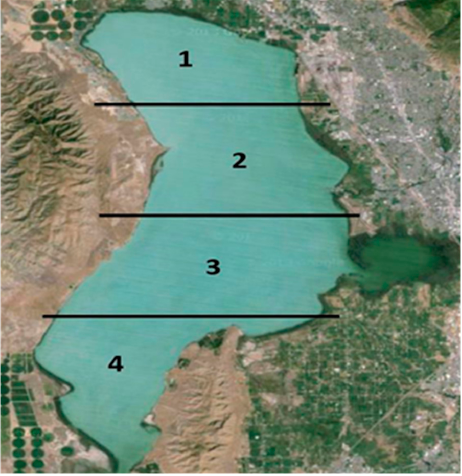
Figure 6. The four sections used for analysis of the Utah Lake sediment data. Table 2. Statistical summary for samples from each of the four lake sections and from the land area. Section